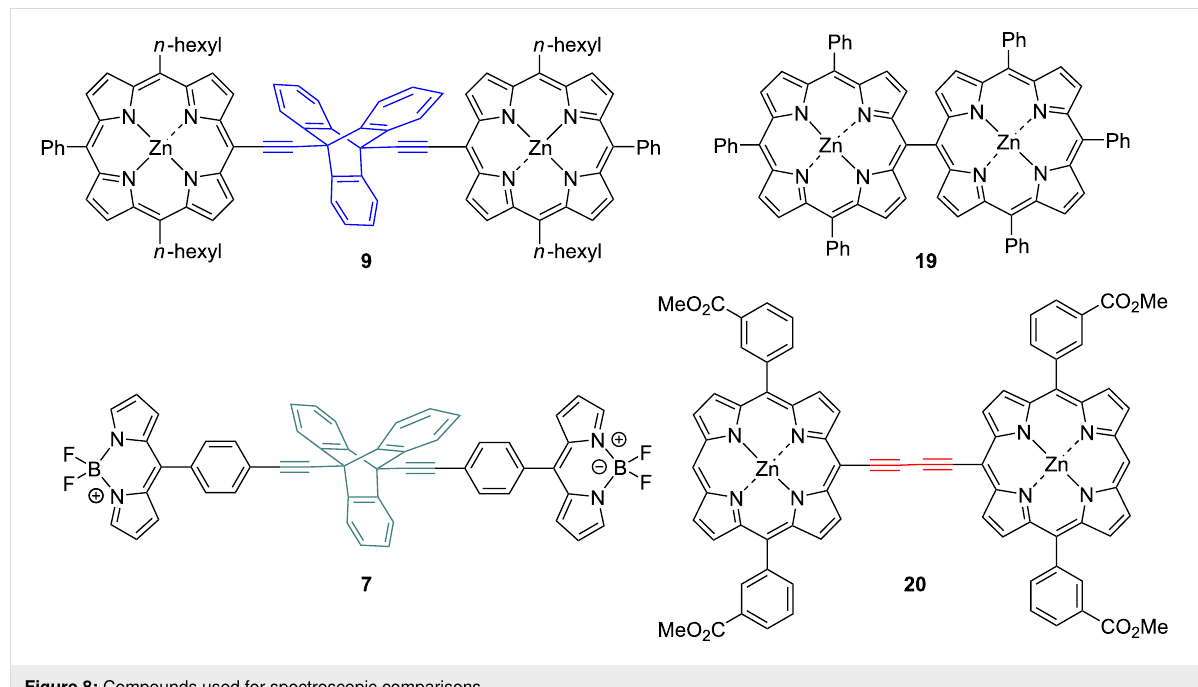
Figure 8: Compounds used for spectroscopic comparisons.